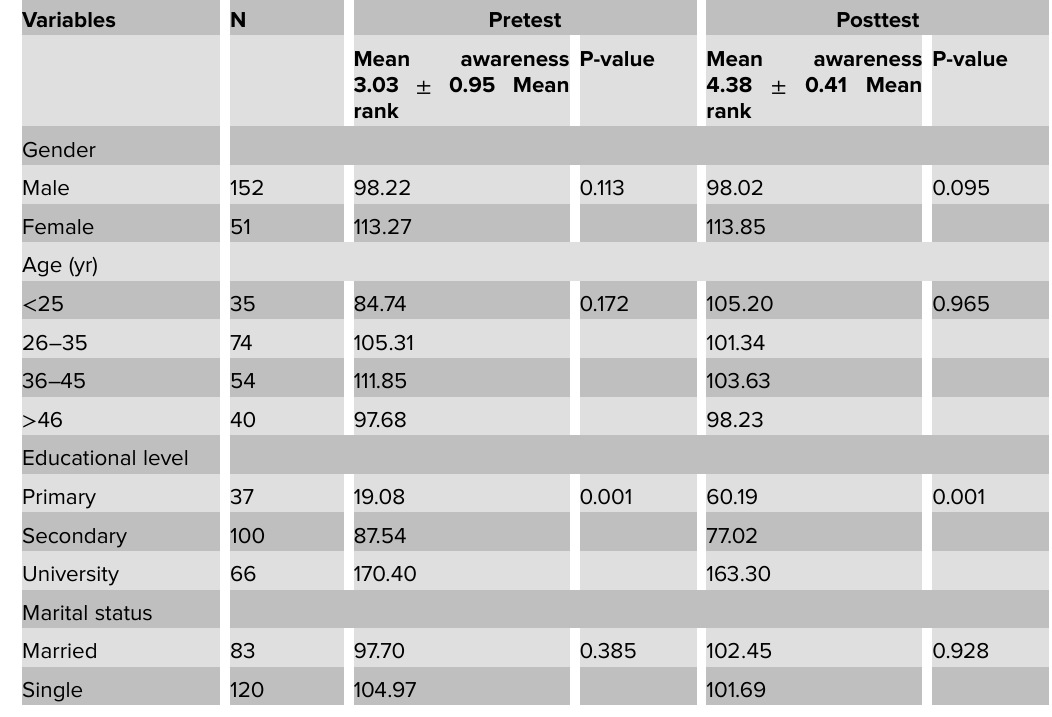
Table 4: Differences in stakeholder’ awareness with demographic variables ( N =